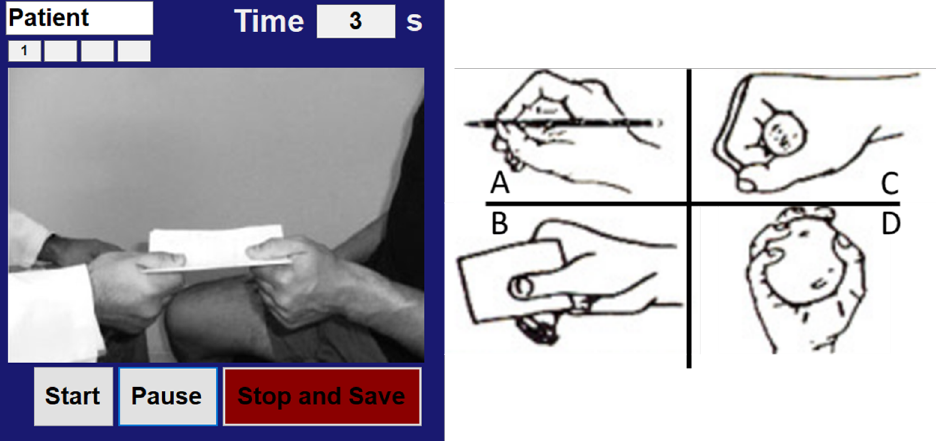
Figure 3. The adopted user interface is reported on the left. The therapist can use the buttons in the bottom to start the timer, pause it, and to stop and save the data. The tasks performed by the patient are reported on the right: grasp a pencil ( A ), grasp a sheet ( B ), grasp a small can ( C ), and grasp a tennis ball ( D